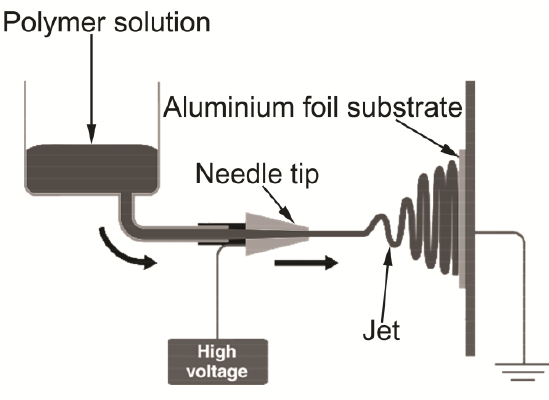
Figure 1. Schematic representation of ES1a electrospinning